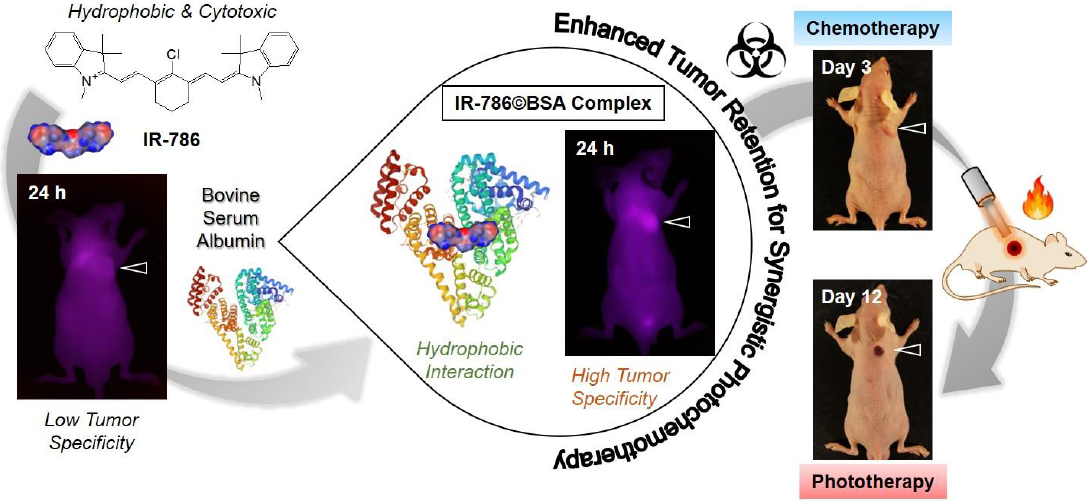
Scheme 1. Schematic illustration of the complex formation between hydrophobic cyanine dye IR-786 and BSA for improved tumor imaging and synergistic photochemotherapy. The albumin-based complex provides a promising strategy for utilizing the hydrophobic and cytotoxic cyanine dyes for various biomedical applications.